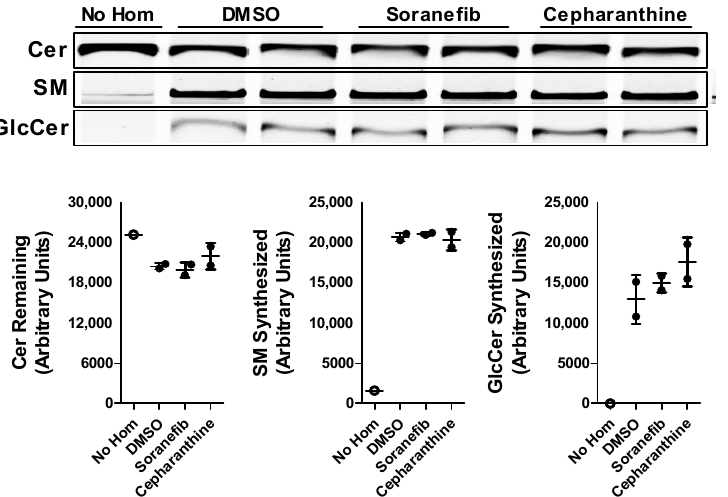
Figure 6. ABCC10 inhibitors does not affect GCS activity. Liver homogenates (500 µ g protein) from wild type mice were incubated with C6-NBD ceramides (3.3 µ g/mL), phosphatidylcholine (100 µ g/mL) and UDP-glucose (500 µ M) in the presence of 5 µ M concentration of either sorafenib or cepharanthine at 37 ◦ C for 1 h. Lipids were extracted from the reaction mixtures, separated on TLC, fluorescence in Cer, SM, and GlcCer bands were visualized with the PhosphorImager (top), and quantified using ImageJ software (bottom). Values are plotted as replicates (mean ± SD).